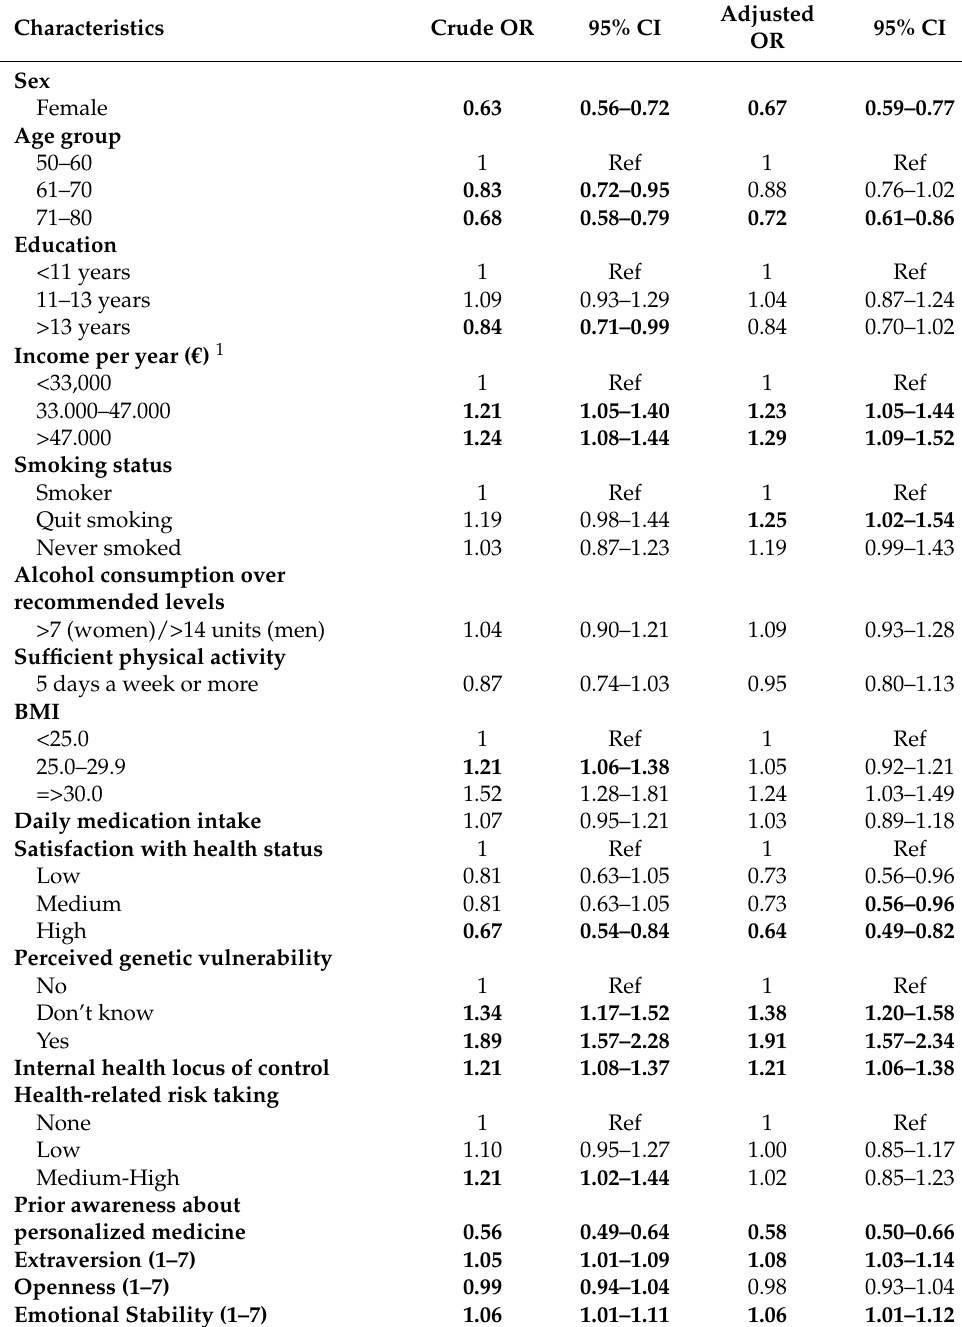
Table 3. Logistic regression model for factors associated with readiness to accept a genetic test for personalized treatment ( n = 6470 for the full